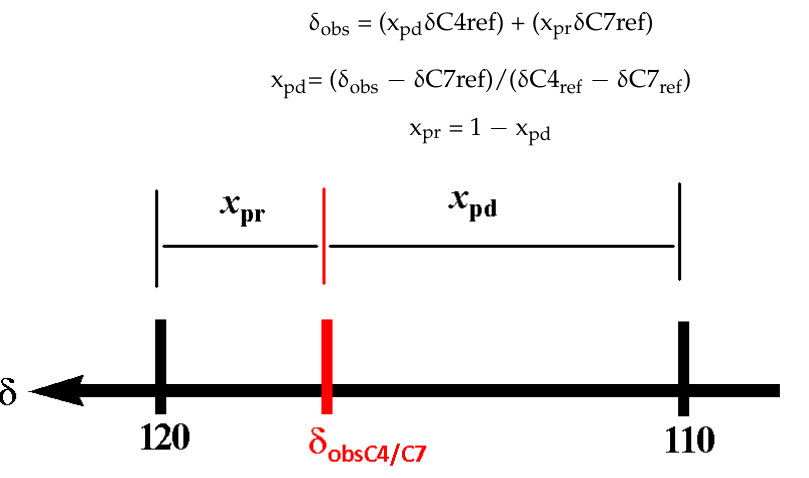
Figure 3. 13 C chemical shifts as references to calculate the tautomeric proportion of pyrrole – pyridine nitrogen atoms.